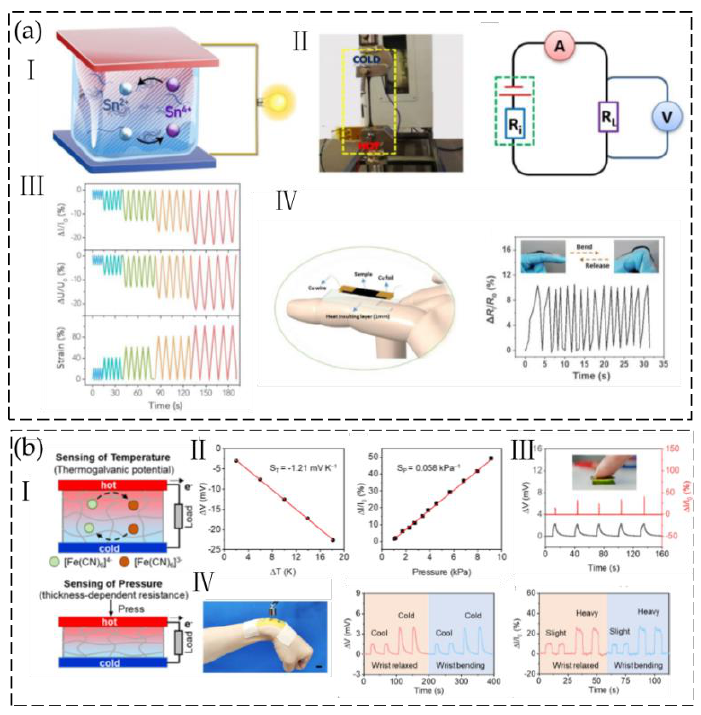
Figure 15. ( a ) I. Hydrogel-based TEC utilizing Sn 4+ /Sn 2+ temperature-dependent redox reactions. II. Experimental set-up and equivalent circuit for the measurement of the self-powered strain sensor. III. Variation in current and voltage for the self-powered TEC sensor. IV. Finger movement monitoring using a self-powered strain sensor. (Reprinted with permission from [106]). ( b ) I. Schematic of temperature − pressure-sensing mechanism. II. Seebeck coefficient fitting relative current change versus pressure of the TGH sensor. III. Responses of a self-powered TGH sensor to finger touch in terms of relative current change and output thermal voltage. IV. TGH sensor array output voltage and relative current change response curves with relaxed and bending states on the human wrist.